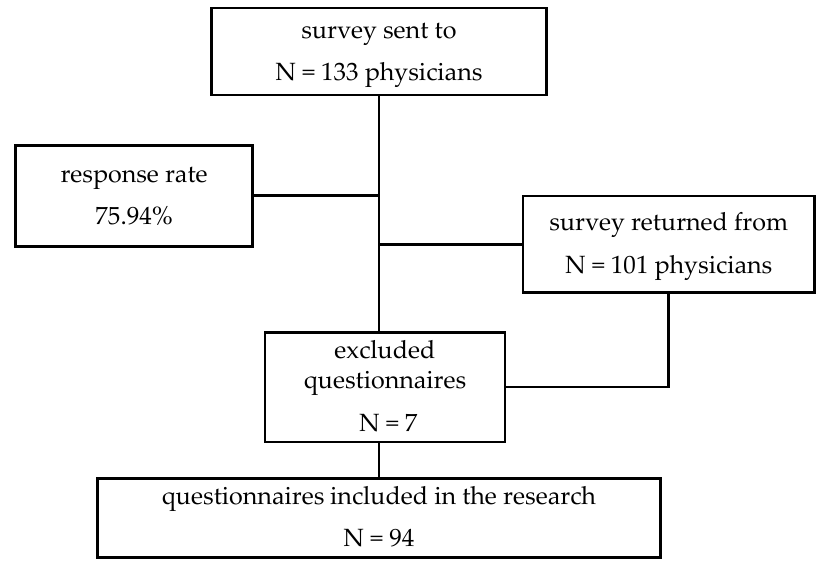
Figure 1. Study profile.